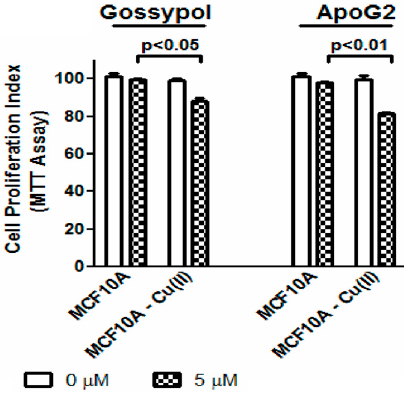
Figure 5. Normal breast epithelial MCF10A cells and MCF10A cells culture media supplemented with 25 µ M of copper (designated as MCF10A-Cu) were treated with 5 µ M gossypol/ApoG2 and cell growth inhibition assay was done by MTT assay as described in the Methods.